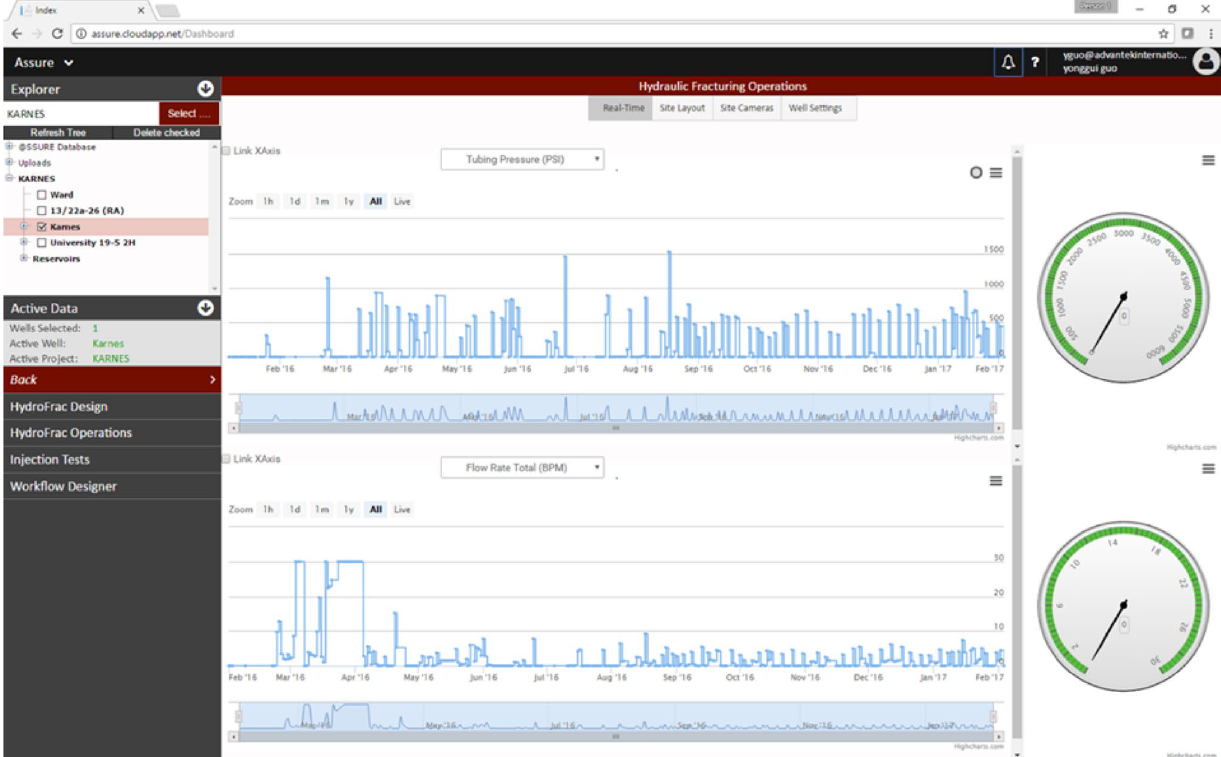
Fig. 6 User interface of the web application for remote real-time monitoring. Real-time injection data are loaded automatically from Azure. Note tubing pressure and flow rate plots only show rough